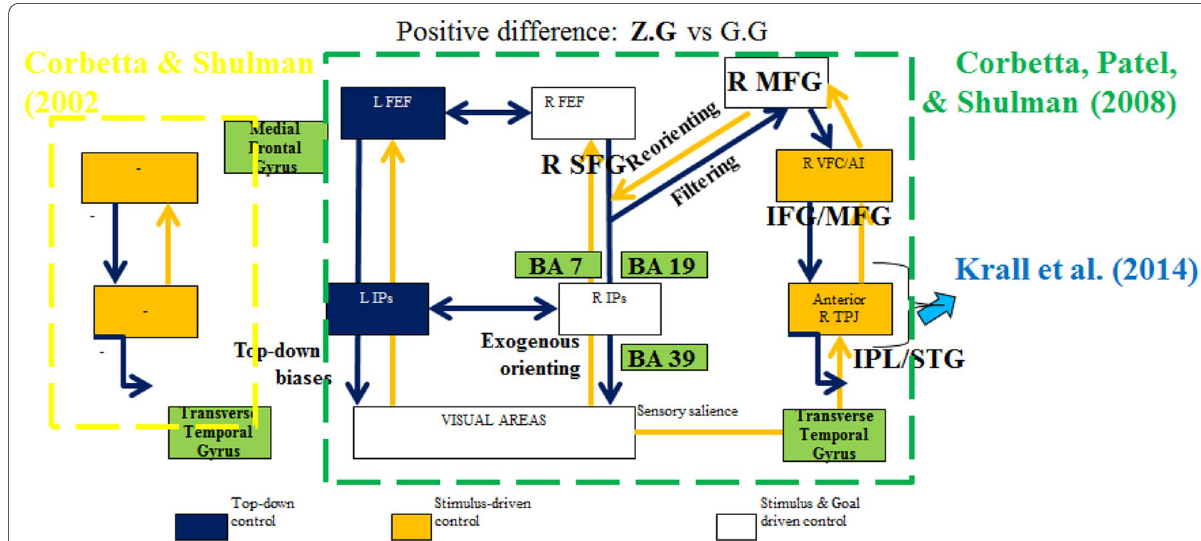
Fig. 4 Comparison of the positive and negative difference of the brain areas for the contrast Z.G vs. G.G, showing an interaction between Filtering and Reorienting mode of